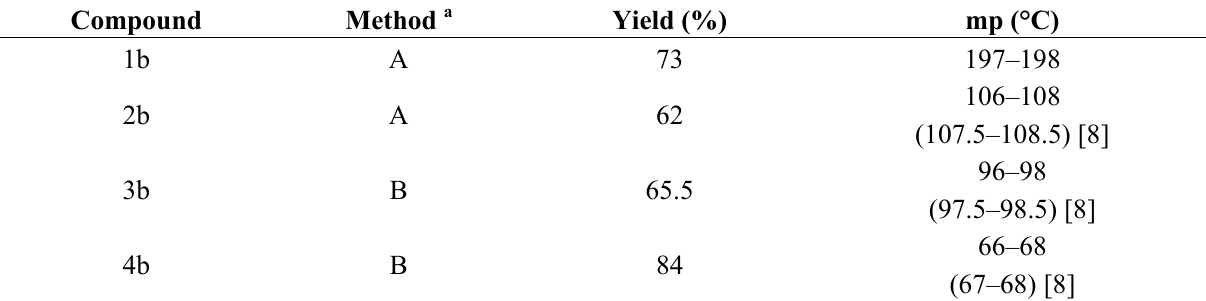
Table 3. Reaction yields and melting points of compounds 1b – 11b